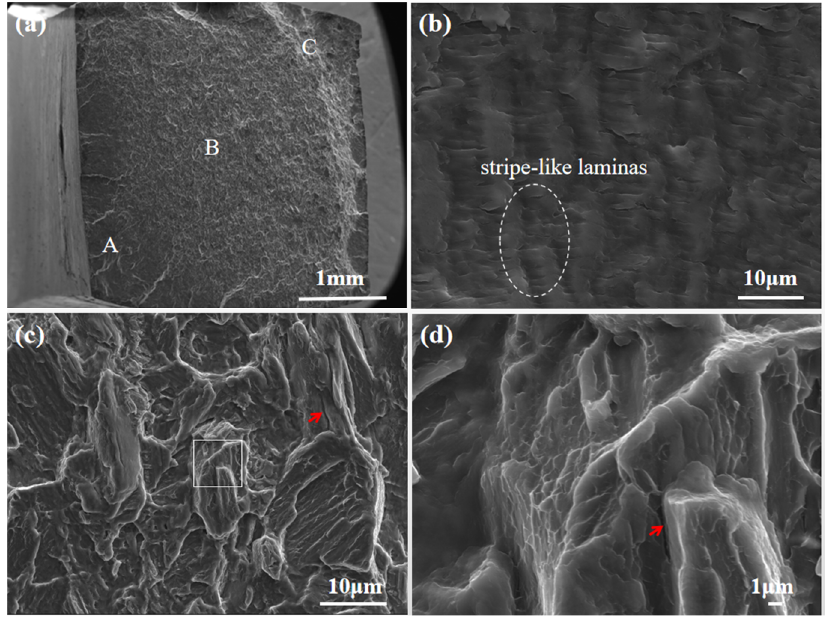
Figure 5. Fatigue fracture morphology of strain amplitude at 1% along ND: ( a ) Typical fatigued fracture regions labeled as crack initiation, propagation, and final fracture; ( b , c ) SEM images from the propagation region showing numerous stripe-like laminas formed in the primary twins; ( d ) High magnification images of the white squares area in ( c ).